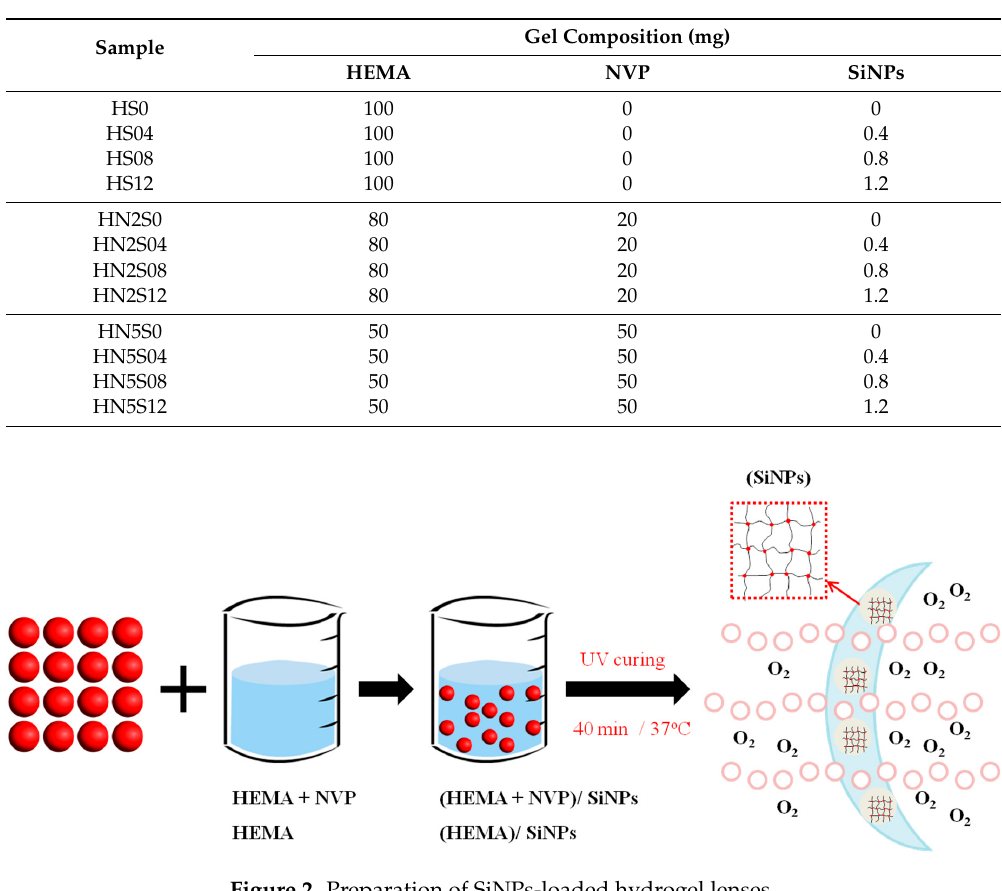
Figure 2. Preparation of SiNPs-loaded hydrogel lenses.